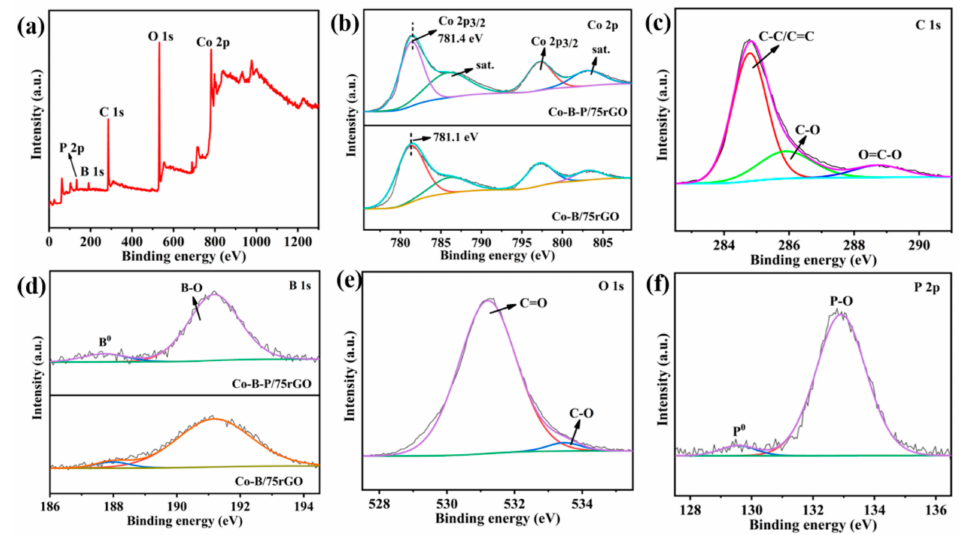
Figure 5. XPS analysis of Co-B-P/75rGO: ( a ) full spectrum, ( b ) Co 2p, ( c ) C 1s, ( d ) B 1s, ( e ) O 1s, and ( f ) P 2p.